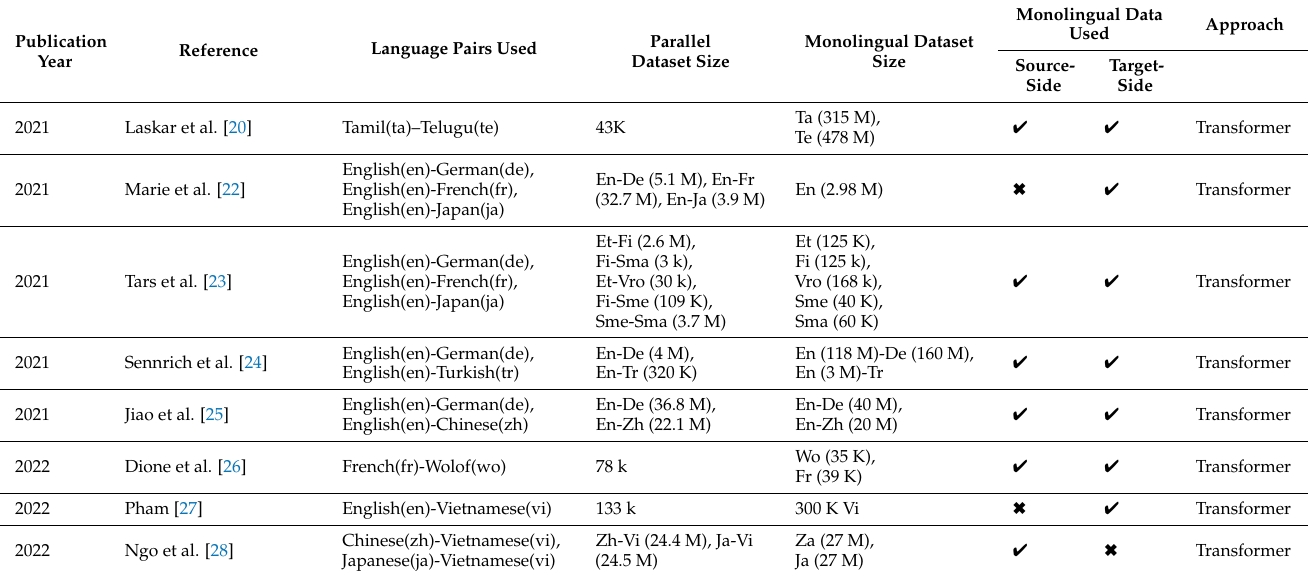
Table 1. Review of different machine translation systems that used monolingual